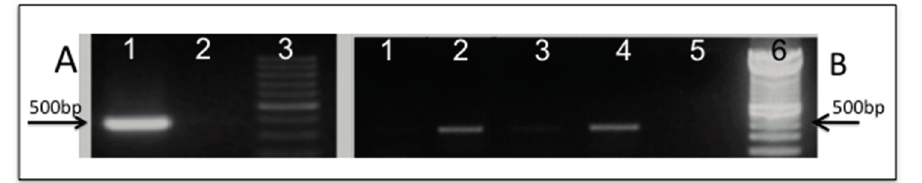
Figure 3. Molecular confirmation of plasmid constructions and yeast transformation